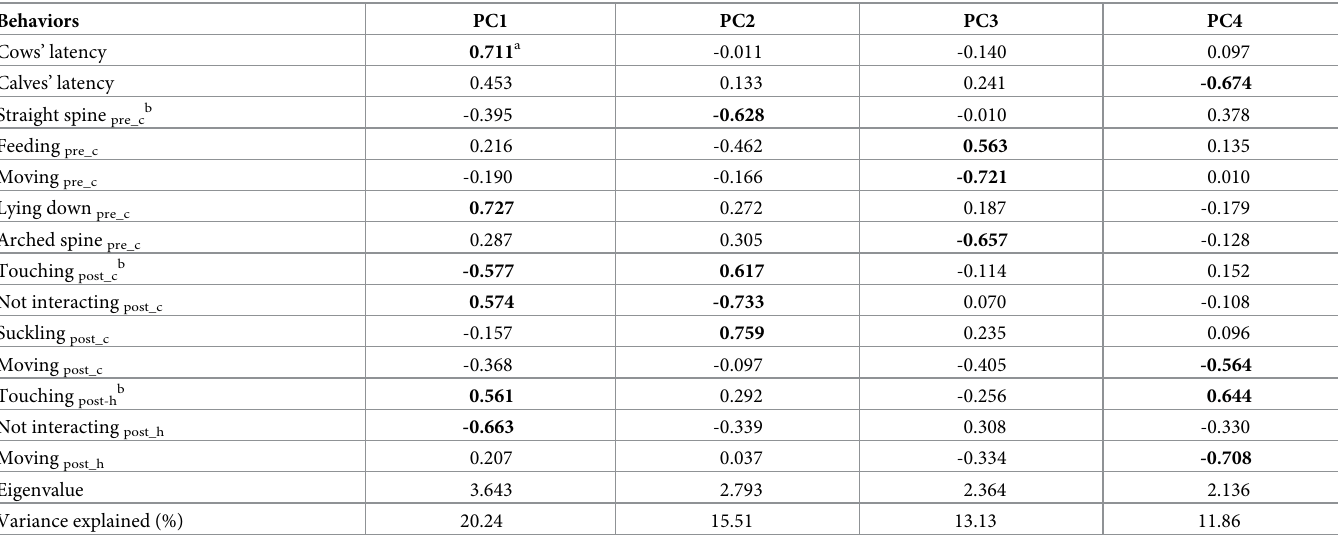
Table 4. Principal components analysis of Gyr cows and their calves’ behaviors in peripartum